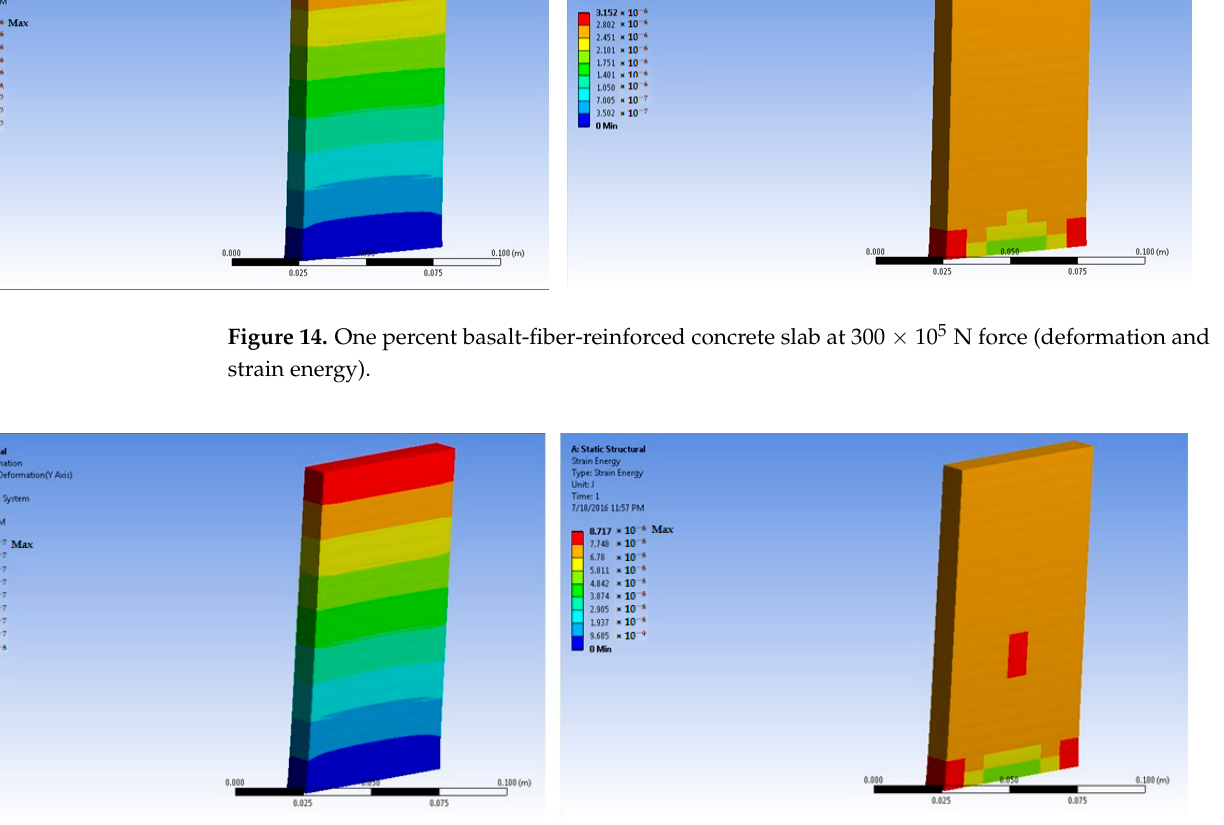
Figure 15. Two percent basalt-fiber-reinforced concrete slab at 50 × 10 5 N force (deformation and strain energy).